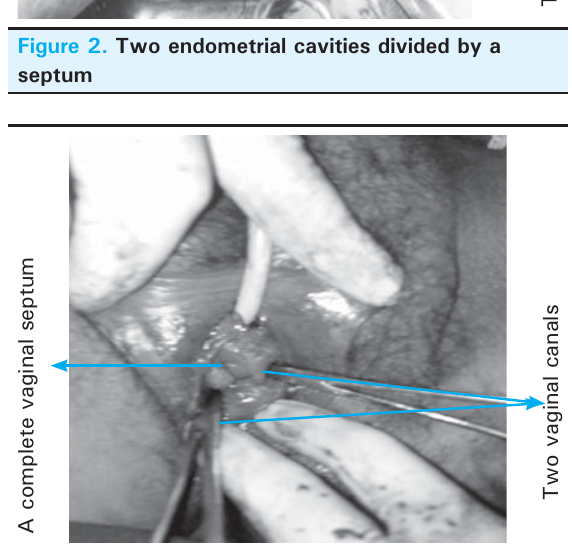
Figure 3. A complete vaginal septum with two